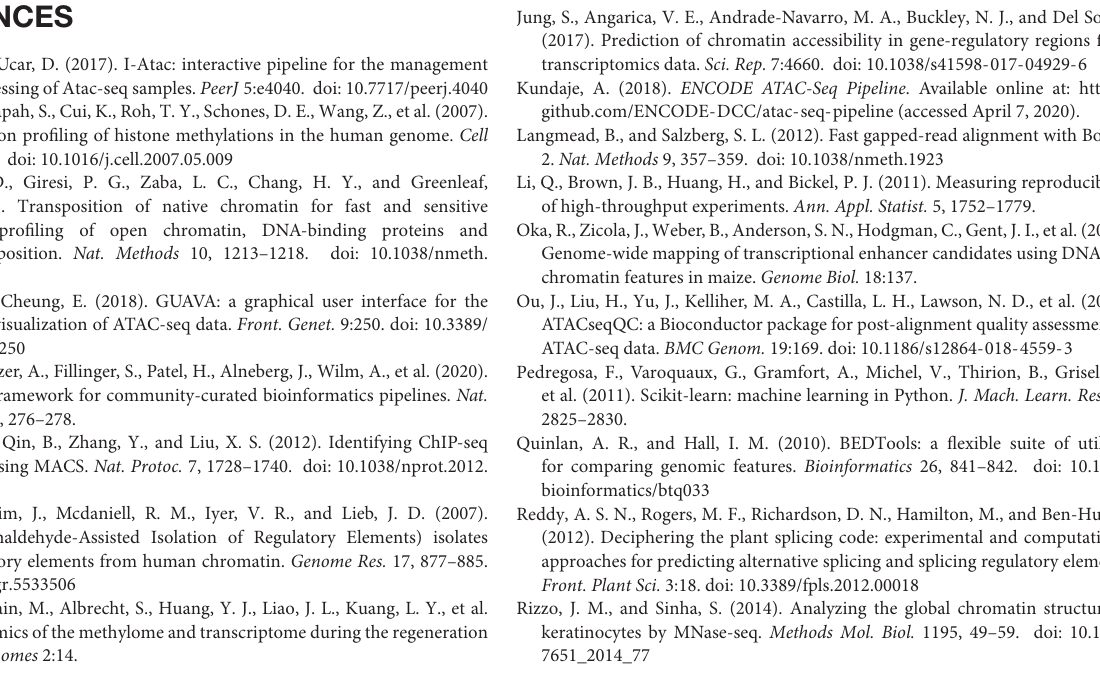
ATAC-seq with RNA-seq. (G) Visualizing the chromatin accessibility and the fold enrichment of open regions in genomic features. Supplementary Table 1 | Functions implemented in the ATACgraph. Supplementary Table 2 | Summary of suggested parameters for fragment length selection and peak calling. Supplementary Table 3 | Command list for mapping